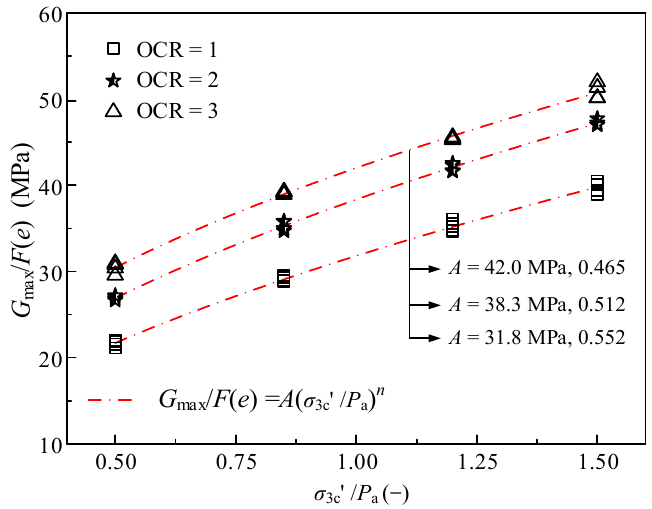
Figure 6. Relationship between G max / F ( e ) and σ 3c ’ / P a.